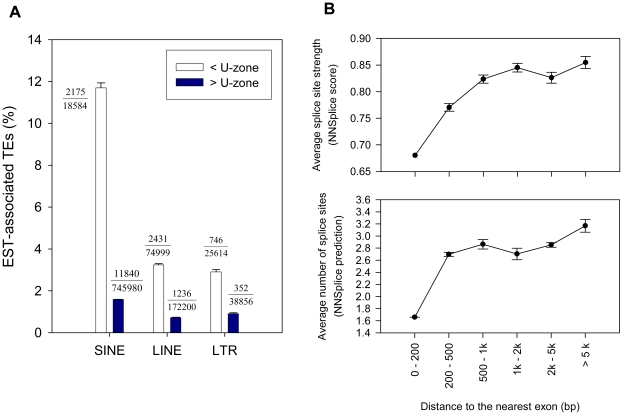
Chimeric transcripts and cryptic splice signals of TEs within and outside the U-zone.A) EST-associated human intronic TEs within and outside the U-zone. Each TE class is shown as a group on the x-axis. The y-axis shows the percentage of intronic TEs that contribute to chimeric ESTs with the enclosing gene. The white/dark bar represents all TEs of each TE class within/outside the U-zone, respectively. The fraction numbers beside each bar indicates the total number of TEs in each category (denominator) and the number of cases involved in chimeric ESTs (numerator). Error bars represent standard errors derived from the total number of cases (sample size) for each category. B) Predicted number and strength of cryptic splice sites in human LTRs. The top panel gives the average strength of predicted splice sites within sampled LTR sequences within each bin (the y-axis) based on the distance from the LTR to its nearest intron boundary (the x-axis). The bottom panel shows the same but for the average total number of predicted slice sites.